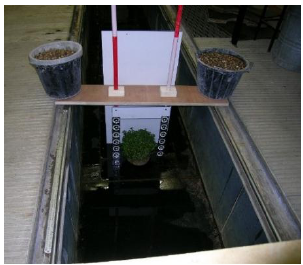
Figure 4. Open-channel flume.